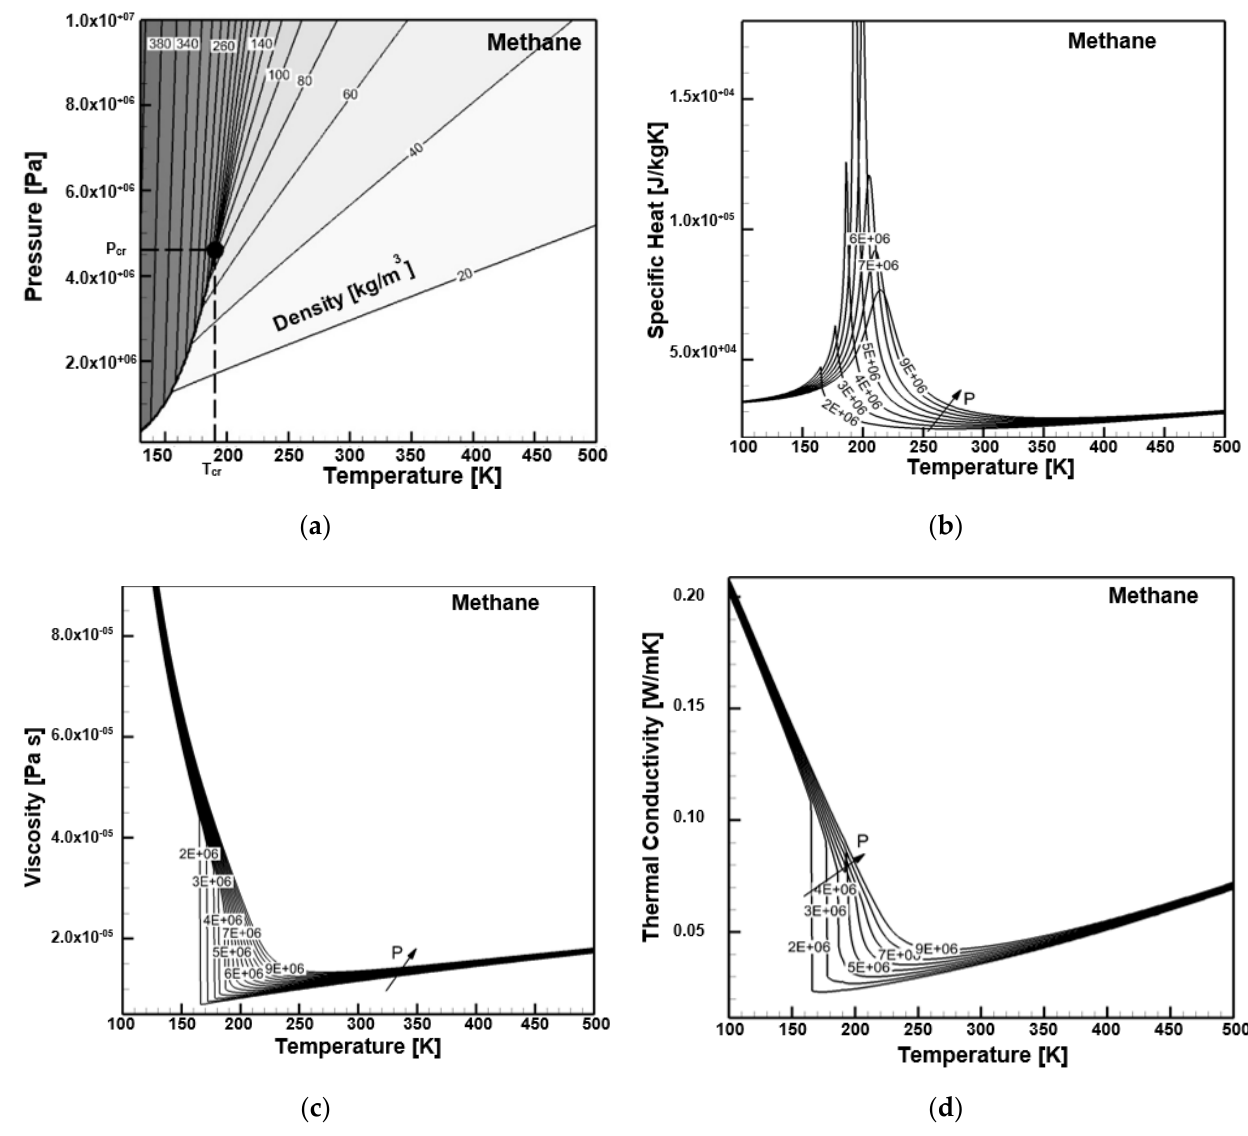
Figure 2. Thermophysical property variations of methane, as a function of temperature and pressure: ( a ) density; ( b ) specific heat; ( c ) viscosity; ( d ) thermal conductivity.